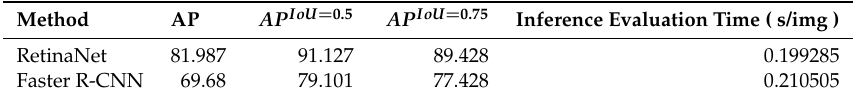
Table 4. Results of AP , AP IoU = .5 , and AP IoU = .75 inference values and time. RetinaNet has the best results for any AP value and inference time.